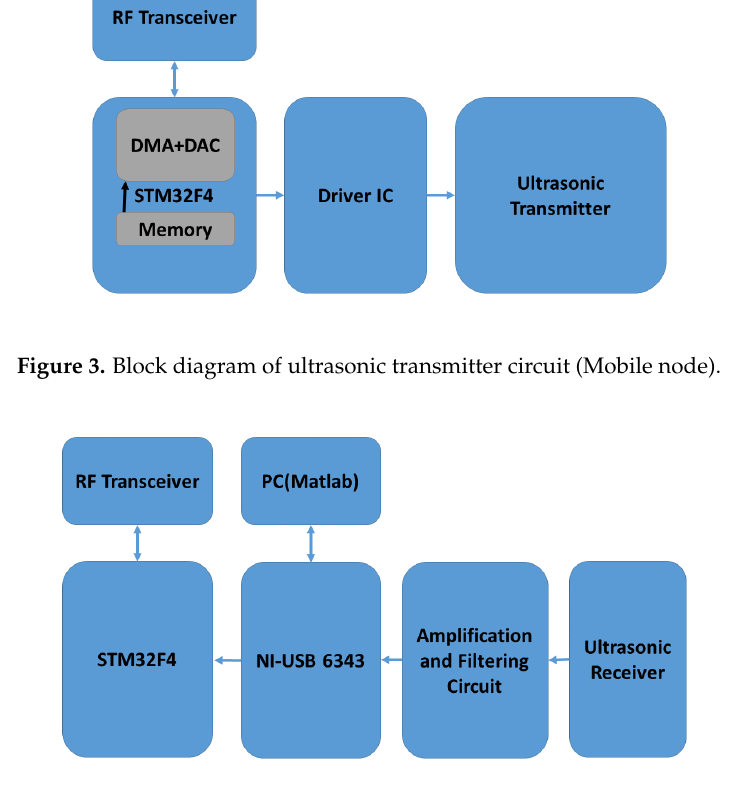
Figure 4. Block diagram of ultrasonic receiver circuit.